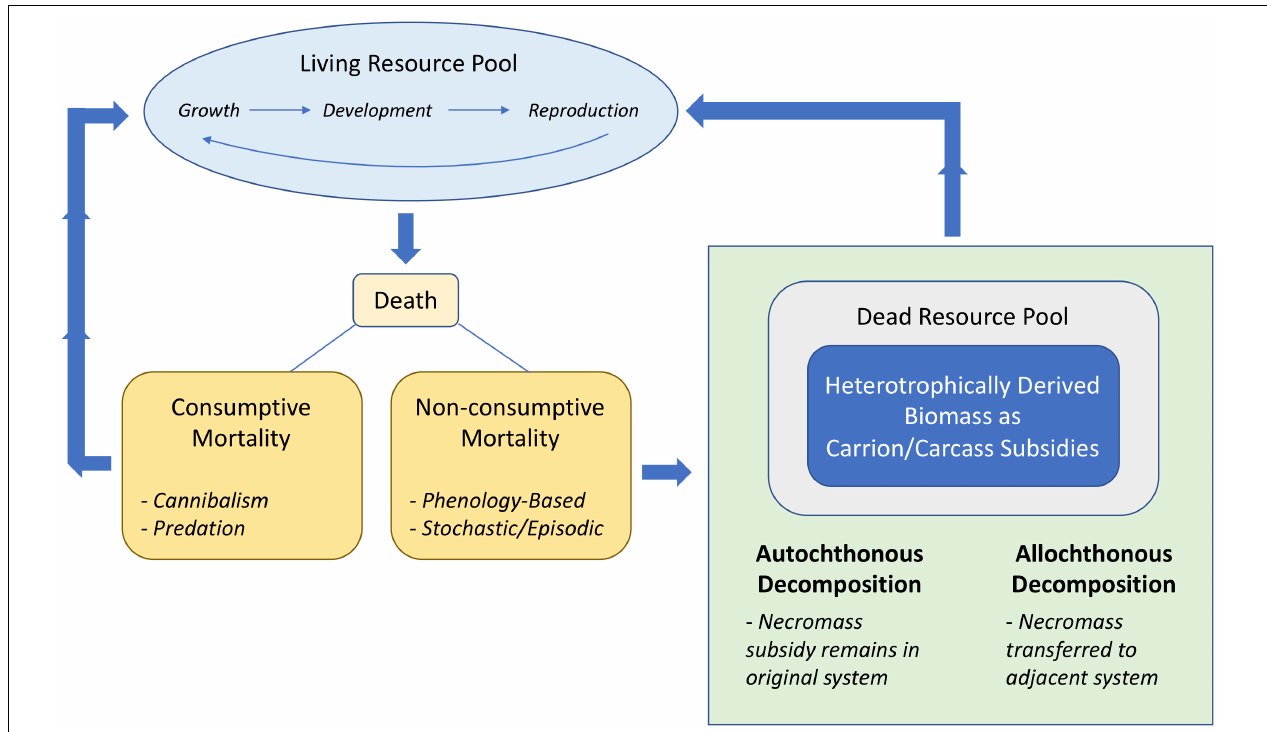
FIGURE 1 | Conceptual diagram linking living resource pools to dead resource pools through the death and decomposition of heterotrophically derived biomass in the form of carrion subsidies. Each species is part of a living resource pool that encompasses growth, development, and reproduction; however, death of a proportion of the living individuals leads to the scavenging or decomposition of the once living biomass (or necromass) that ultimately becomes incorporated into the living resource pool through food web interactions. Death can come in the form of consumptive mortality (i.e., cannibalism or predation) where the nutrients and energy of dead organisms goes back to the living resource pool. Death can also come in the form of non-consumptive mortality, as part of natural senescence of the life cycle that can be through phenology-based (e.g., salmon life cycle) or stochastic/episodic (e.g., mass mortality of bivalve populations) processes. The resulting decomposition of these carrion subsidies can be autochthonous or allochthonous, depending on the life history and range of the once living species, affecting energy and nutrient flow within and among ecosystems.